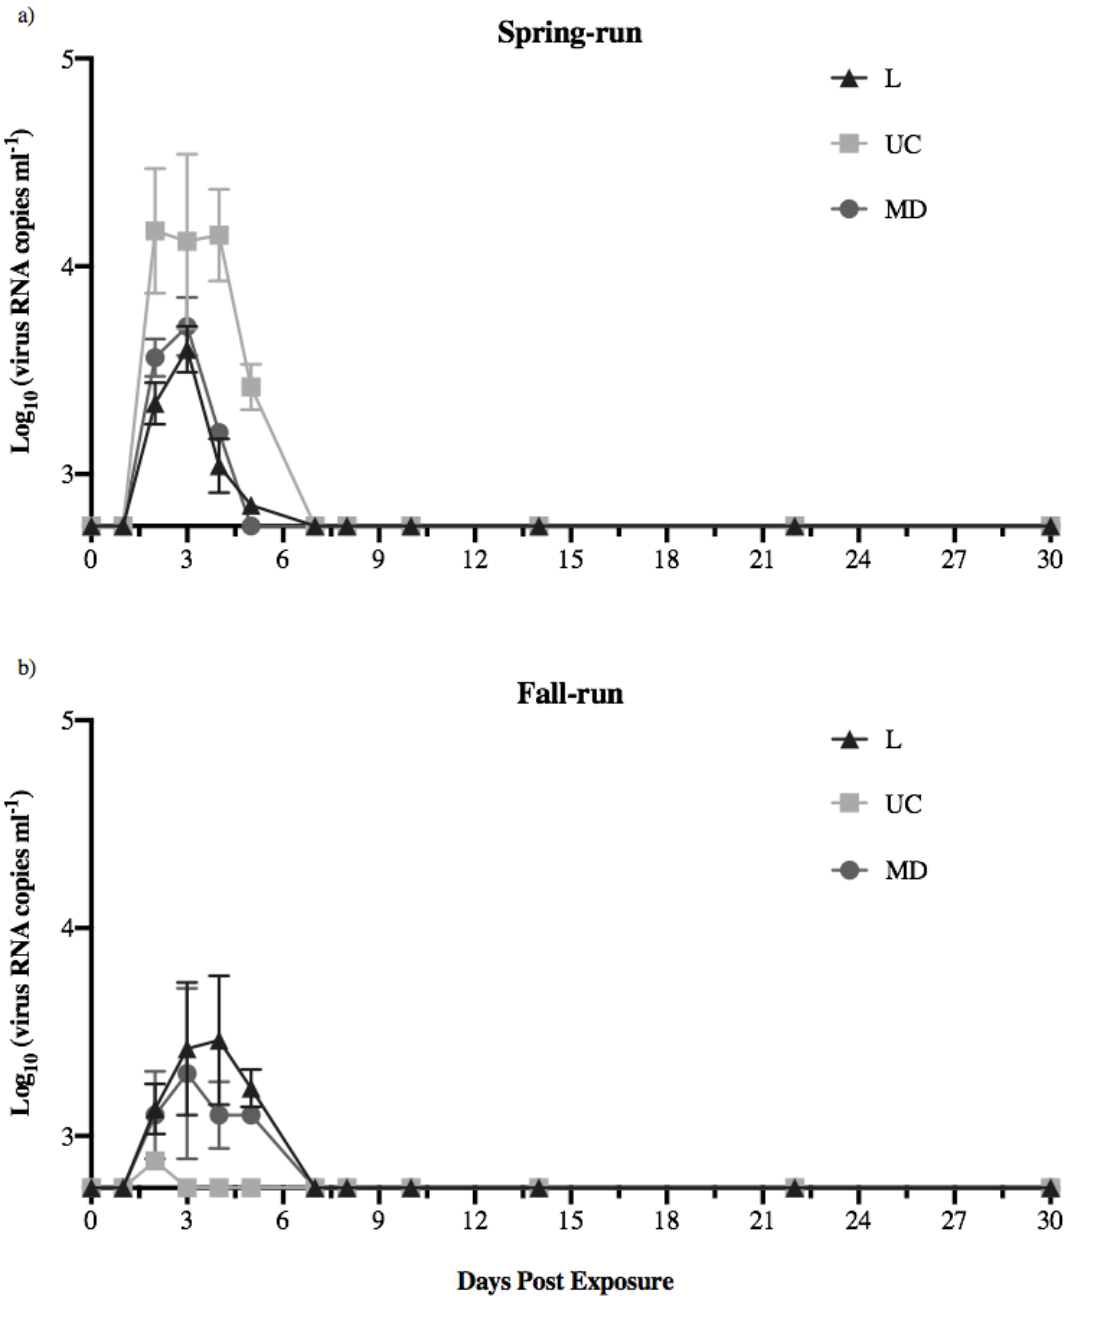
Figure 3. Mean shedding kinetics of L, UC and MD IHNV in ( a ) spring- and ( b ) fall-run Chinook salmon of the CRB. Data are mean (± 1 standard error) virus quantities shed daily for all fish that shed virus on each day in each treatment group. The detection limit of the universal N-gene IHNV rPCR assay (2.75 log 10 RNA copies mL −1 ) is reflected as the base of the y -axes. Peak viral shedding for each of the 34 fish that shed detectable virus was determined as the data point showing the highest shed viral load for each fish. The mean day of peak shedding for each treatment group varied between day 2 and 3, and there were no significant differences between IHNV treatments or across host populations (ANOVA, p > 0.05) (Figure 4a). The mean quantity of peak virus shed in each treatment group ranged from 2.88–4.22 log 10 viral RNA copies mL − 1 (Figure 4b, Table S1). The highest and lowest peak-shedding values were both for UC virus, with a 22-fold difference